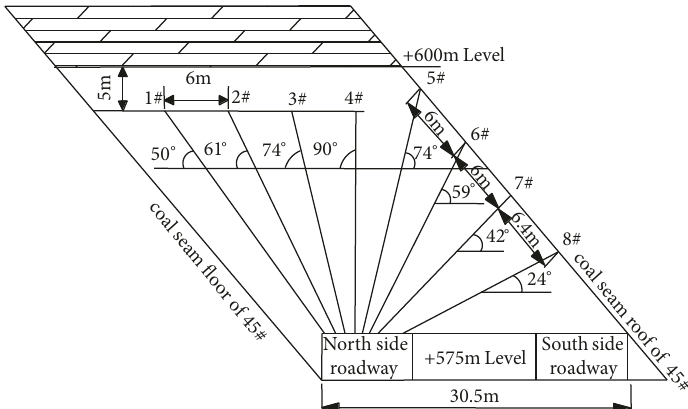
Figure 5: Schematic diagram of drilling and controlling H 2 S in prefilled absorbing liquid of steeply inclined thick coal